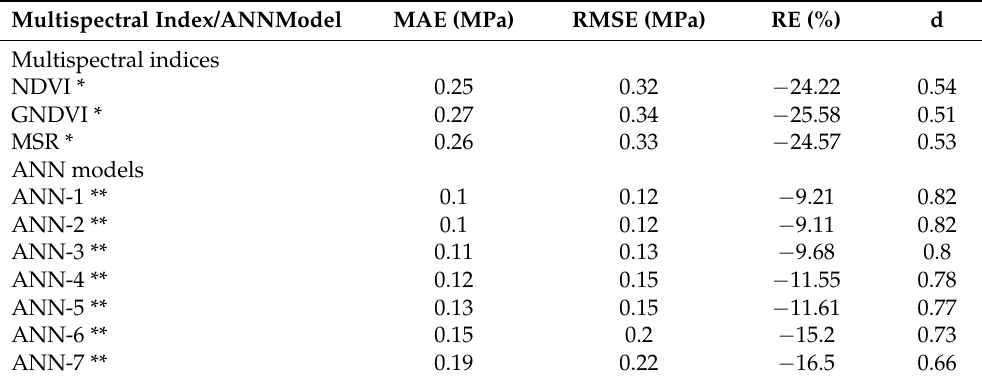
Table 5. Statistical parameters of validation for conventional indices and artificial neural network (ANN) models.